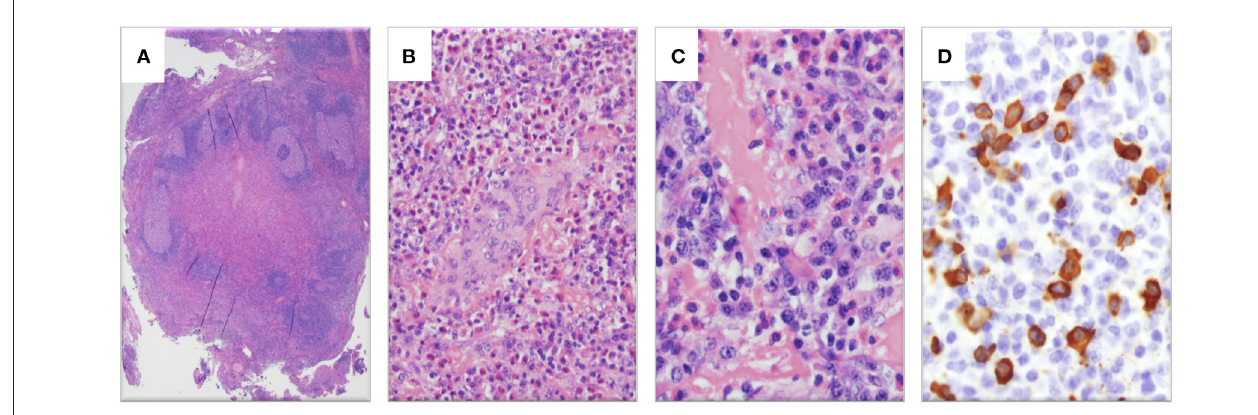
FIGURE 2 | Histopathologic examination of left neck mass. (A) Hematoxylin and eosin (H&E)-stain showing lymphoid tissue with marked interfollicular expansion and reactive follicles (1.25 × ). (B) H&E-stain showing prominent eosinophilia and plasmacytosis together with plump endothelial cells (20 × ). (C) H&E-stain revealing a fibrotic process with elevated plasma cells and eosinophils (40 × ). (D) Abundant IgG4-stained cells ( > 60 per high powered field, 40 ×